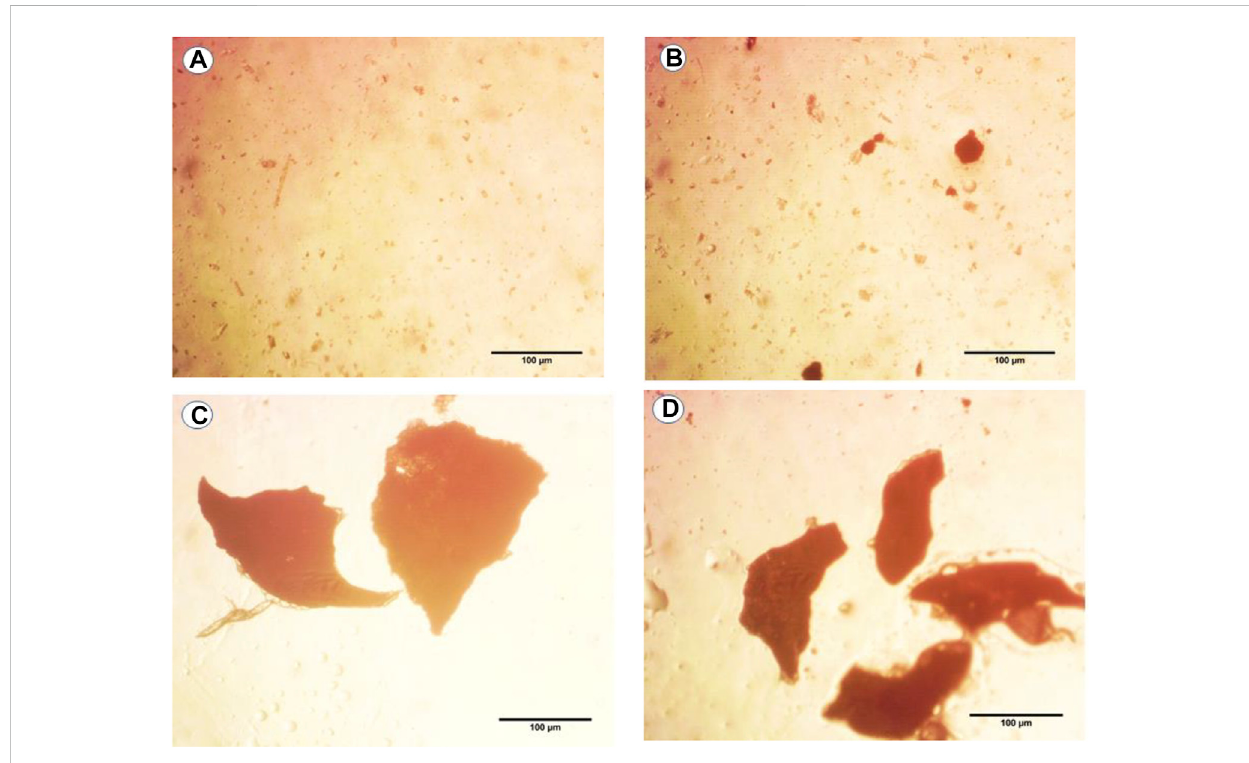
Photographs of lightimages of microplastics (MPs)found in dissolved mouse tissues inhydrogenperoxide solution after exposureto (A) control, (B) 6 μ g/ml MPs, (C) 60 μ g/ml MPs, and (D) 600 μ g/ml